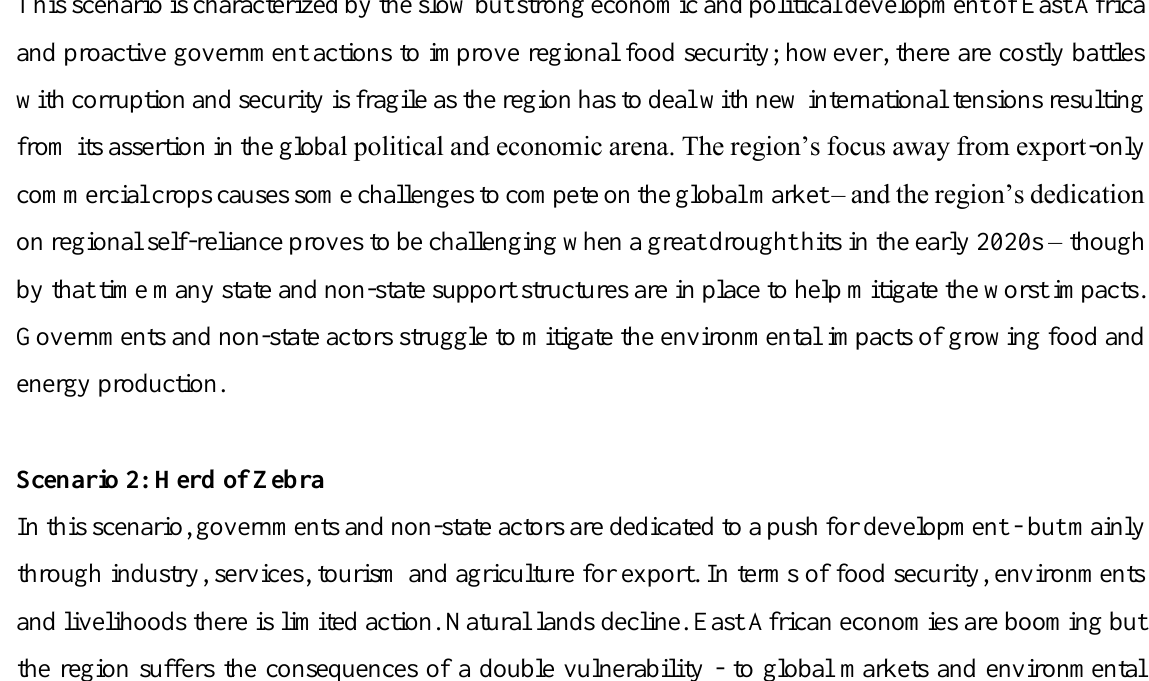
Figure 1. Cartoon representations of the CCAFS East Africa scenarios (from Vervoort et al. 2013) Scenario 1: Industrious